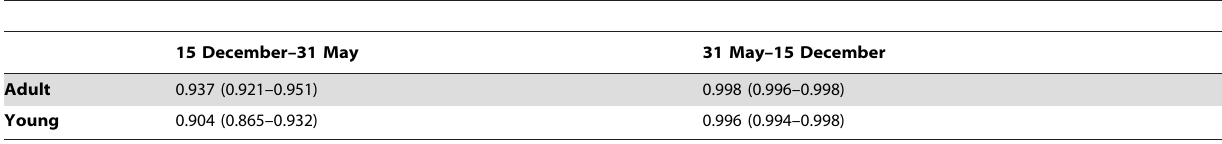
Table 3. Monthly survival probabilities of pochards ringed on Grand-Lieu in both the wintering and the breeding